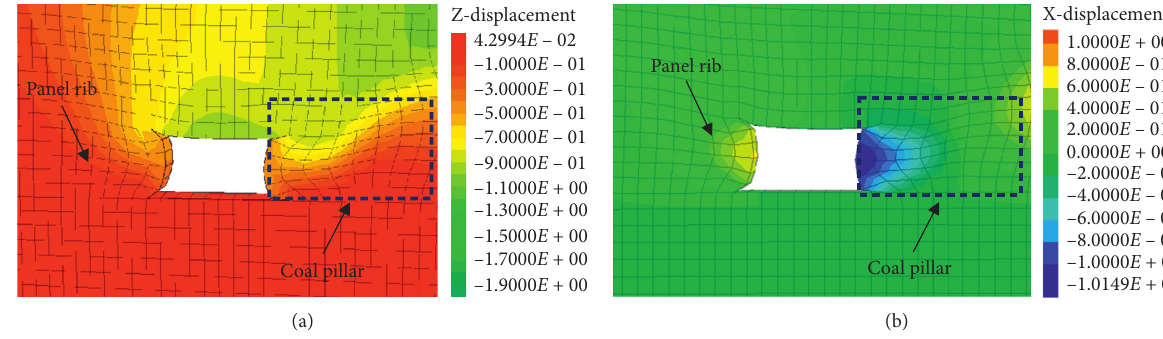
Figure 3: Displacement distribution developed around the gob-side entry in section 8211: (a) vertical displacement; (b) horizontal displacement.